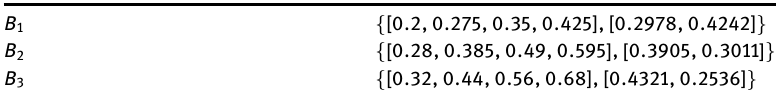
Table 7: Preference Intuitionistic Trapezoidal Fuzzy Values. B 1